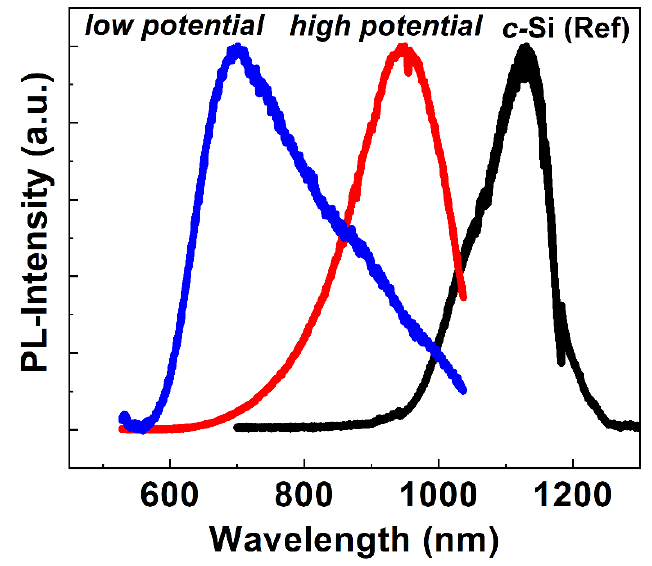
Figure 9. Normalized PL spectra of electrodeposited Si-layers obtained at reduction potentials set as low and high potential .